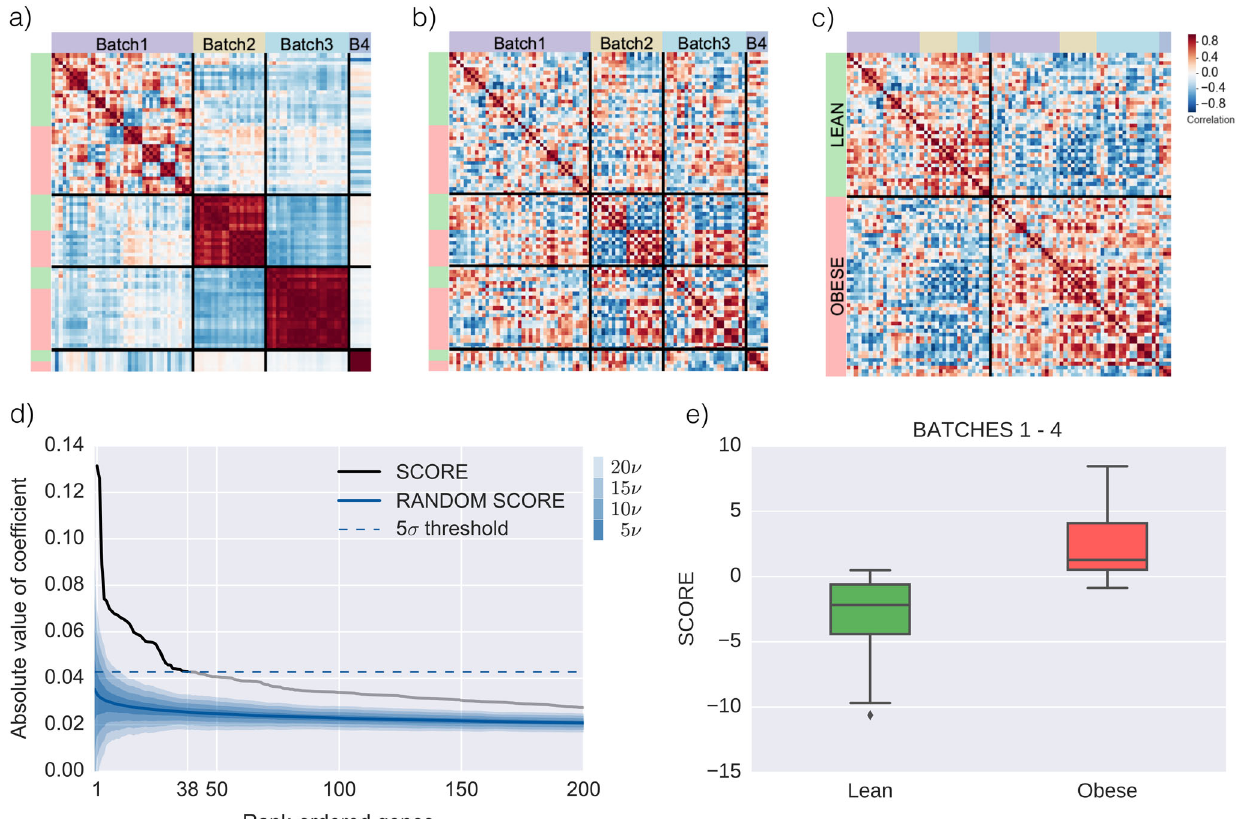
Fig. 1 Merging different data sets leads to a strong signature. a , b , c : Visualization of the batch-effects removal process. Heatmaps showing correlations among samples before a and after b , c the application of our two-step singular value decomposition (SVD) fi ltering process, see Methods for details. Red indicates positive correlation, while blue indicates negative correlations. Samples are grouped by batch in panels a , b and by Body Mass Index (BMI) status in panel c . Correlations are computed using only the fi rst seven principal components to enhance visualization. d Signi fi cance of the obesity score coef fi cients. The 200 genes with highest coef fi cient (in absolute value) in the fi rst principal component of Batch1 – 4 after SVD fi ltering ( black and gray line ) and in a random vector ( solid blue line ), see Methods for details. The dashed blue line marks the 5- σ signi fi cance threshold used to extract the 38 genes of our obesity signature. The 4 blue shaded regions (ranging from darker , more probable, to lighter , less probable), mark increasing intervals of 5 ν , where ν is the standard deviation of each individual ranked gene in a randomized score. e Obesity score at different BMI status. Obesity score boxplots for patients categorized either as lean or obese for Batch1 – 4. Notice that this batch is also used to construct the score. For validation data, see Figure